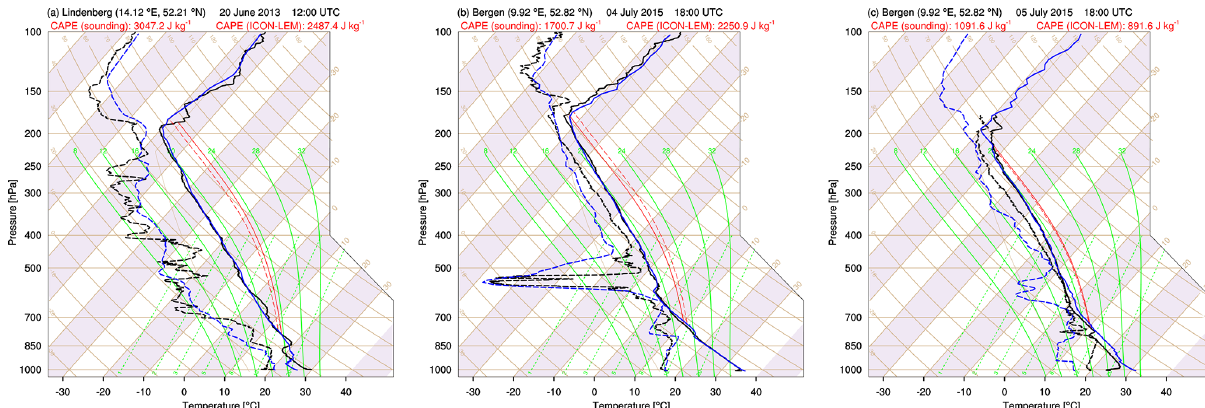
Figure 2. Comparison of vertical profiles plotted on a Skew-T, log-P diagram for the three simulated days. The location and start of ascent are given on top of each panel, approximately matching the point in time of the synoptic situations in Fig. 1. The sounding profile is depicted in black, whereas blue lines display simulated profiles (solid lines: temperature; dashed lines: dew-point temperature). Unstable regions are highlighted with red lines, illustrating the CAPE values given on top of each panel (solid red lines: CAPE of the sounding; dashed red lines: simulated CAPE). All other basic lines are isobars (in hPa; horizontal brown lines), isotherms ( ◦ C; solid brown lines sloping from the lower left to the upper right), dry adiabats ( ◦ C; slightly curved, solid brown lines sloping from the lower right to the upper left), saturation adiabats ( ◦ C; slightly curved, solid green lines), and saturation mixing ratios (gkg − 1 ; almost straight, dashed green lines starting from the lower left to the upper